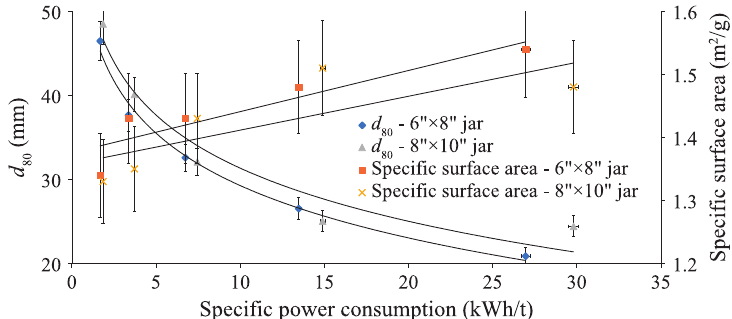
Fig. 6 Specific power consumption as a function of d 80 and specific surface area—Vale Sossego sample 2.